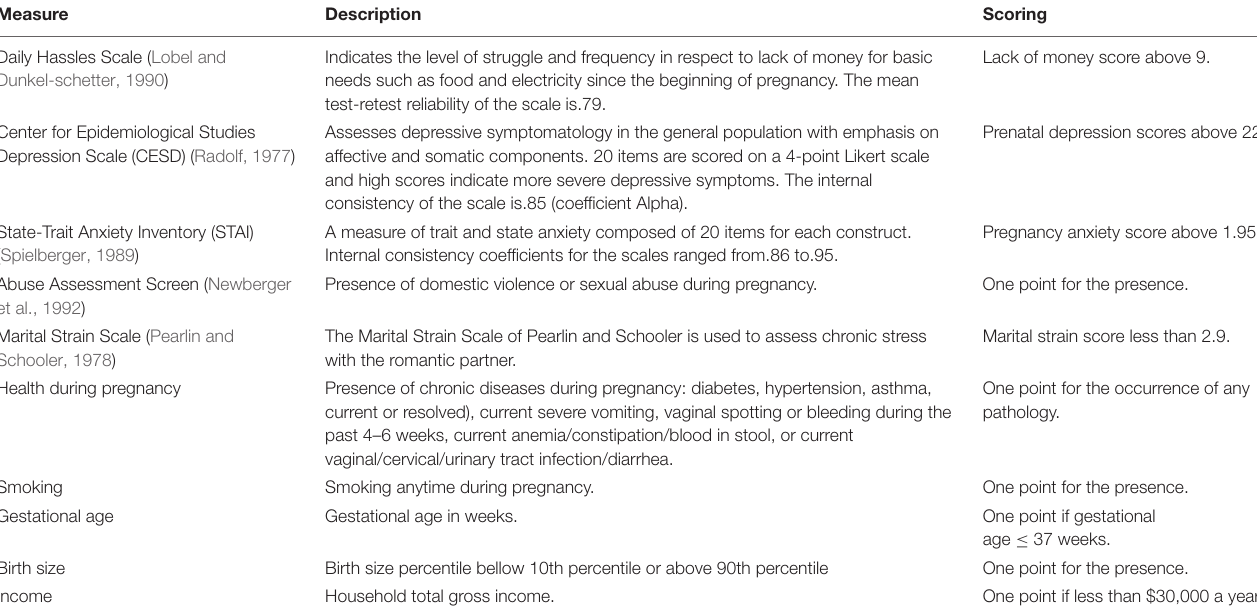
Lack of money score above